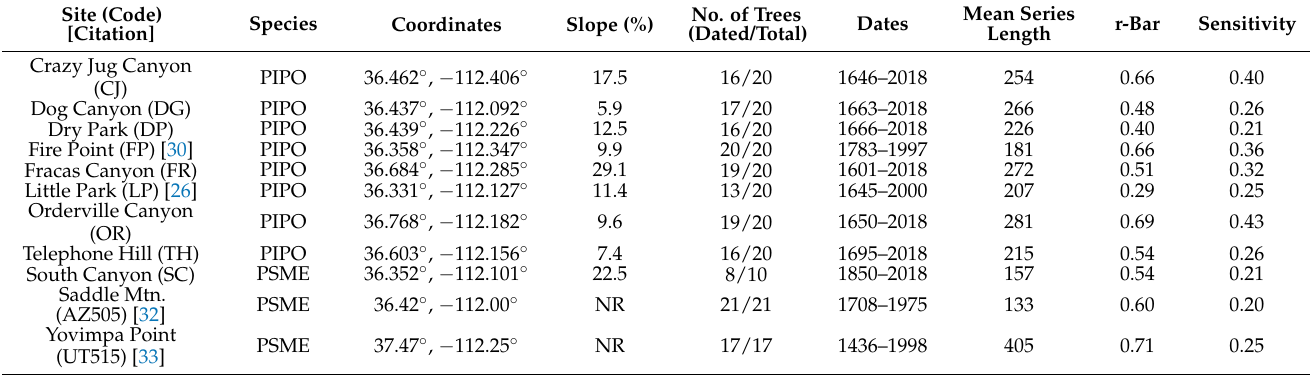
Table 1. Site chronologies and associated metadata. NR = data not reported by the original authors. Species codes are created from the first two letters of the genus (e.g., PInus ) and species ( POnderosa